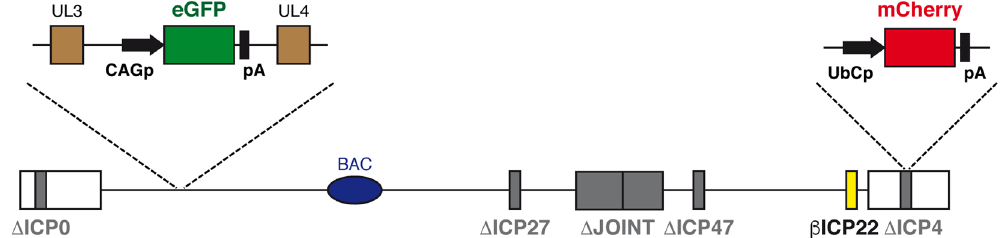
Figure 1. Graphic map of the J Δ NI6 vector genome. The vector is deleted for the joint region, including the ICP47 promoter and translation initiation codon, and for the ICP0, ICP4 and ICP27 IE genes ( Δ ; gray boxes). Additionally, the ICP22 IE gene is converted to early-expression kinetics ( β ; yellow) by promoter TAATGARAT deletion. The vector hosts two expression cassettes for reporter genes: eGFP (green) between the U L 3 and U L 4 genes and mCherry (red) in the deleted terminal ICP4 locus. The eGFP gene is driven by the CAG promoter (CAGp), while the mCherry gene is driven by the ubiquitin promoter (UbCp). The BAC elements, including a chloramphenicol-resistance gene and β -galactosidase expression cassette, are located between loxP sites in the U L 37-U L 38 intergenic